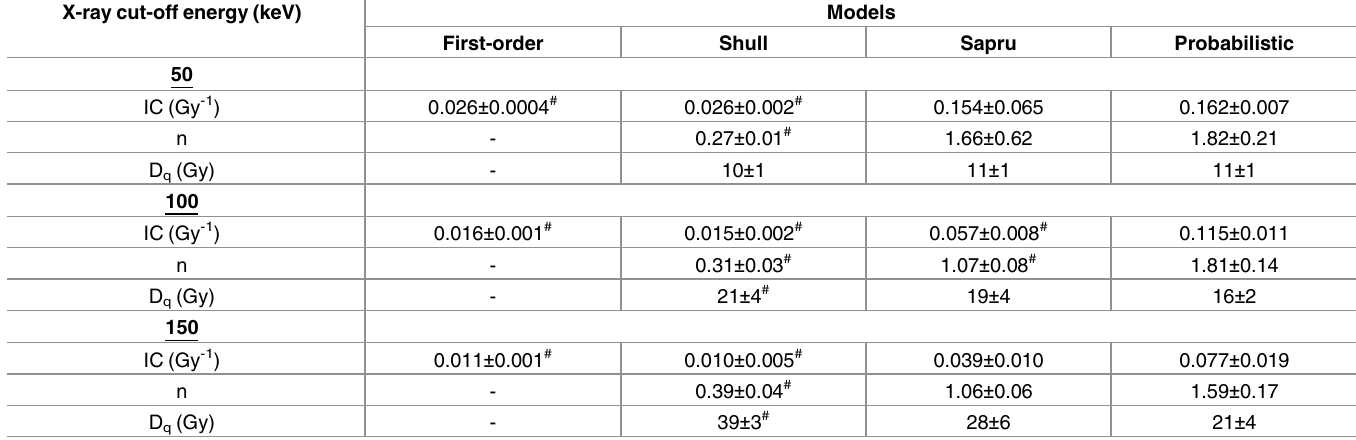
# indicate reduction dose values that are significantly different (P (cid:20) 0.05 based on a two-tailed paired t-test) from the